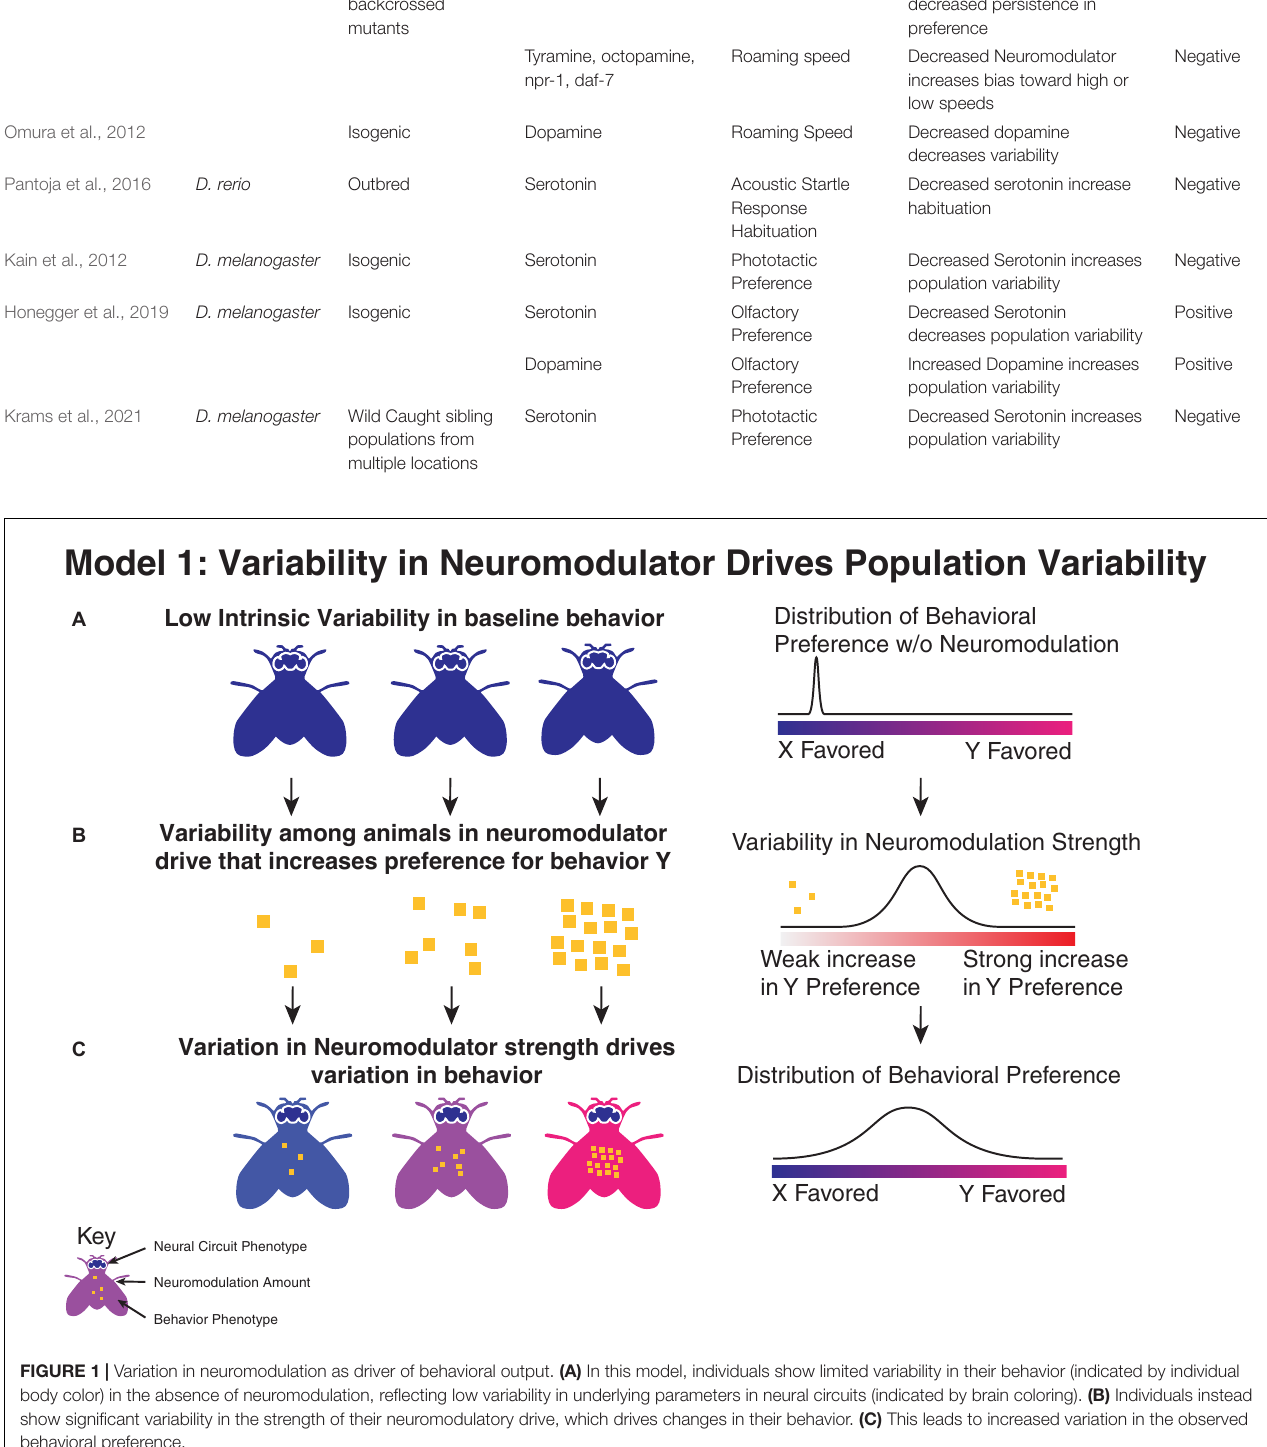
Frontiers in Behavioral Neuroscience |